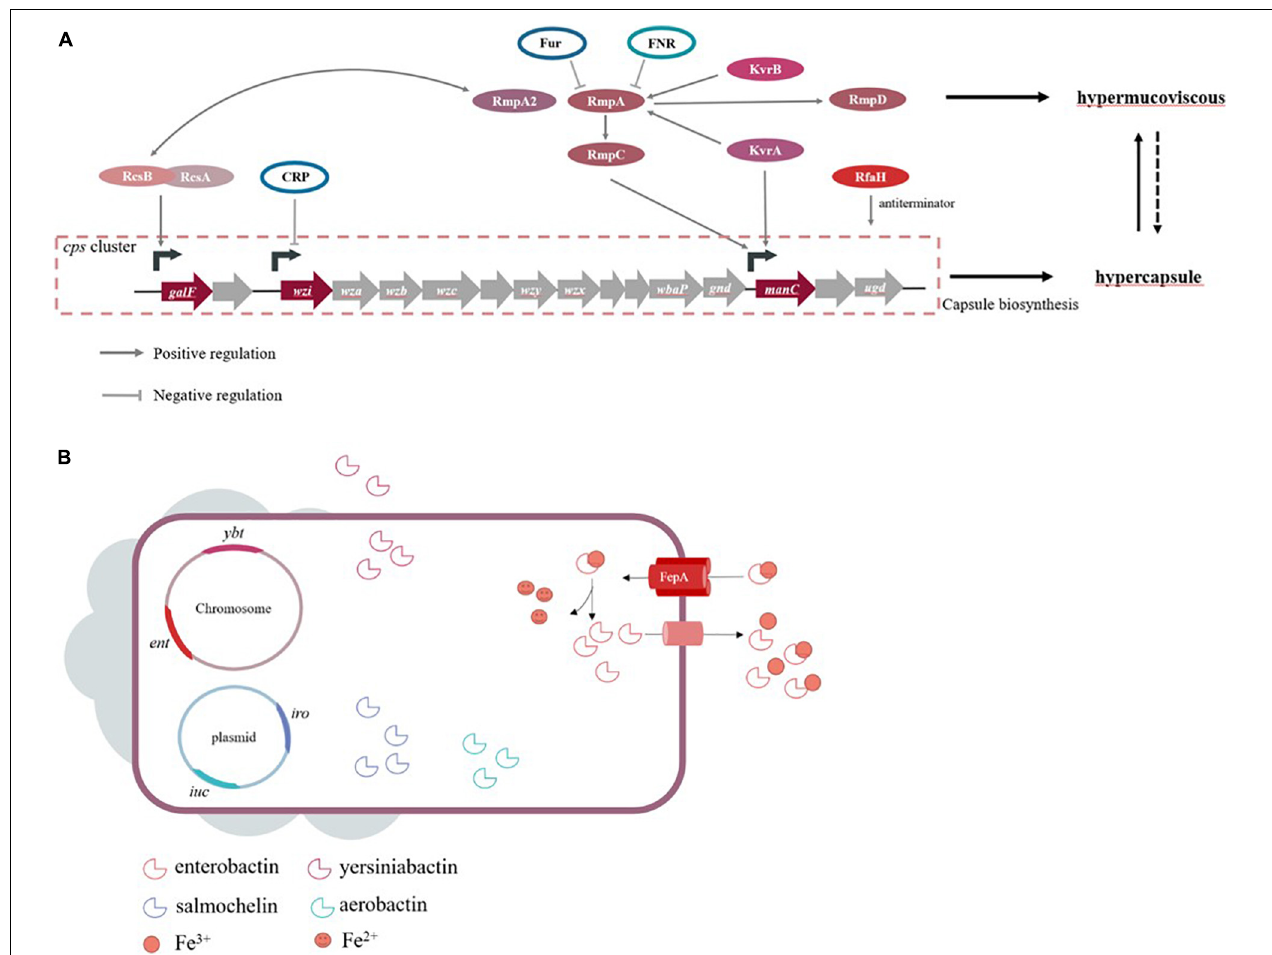
FIGURE 1 | (A) Genes are known to influence capsule biosynthesis, including genes at cps locus and regulators affecting the cps expression directly or indirectly. The corresponding promoters that some regulators act on refer to studies of Walker and Miller (2020). Hypercapsule is sufficient but not necessary for hypermucoviscous phenotype, demonstrating that hypermucoviscous phenotype is not solely due to excessive capsule expression. (B) The siderophore systems enterobactin (ent) , yersiniabactin (ybt) , salmochelin (iro) and aerobactin (iuc) are present. Take enterobactin as an example to show the process of iron acquisition, which FepA is the transporter specific to